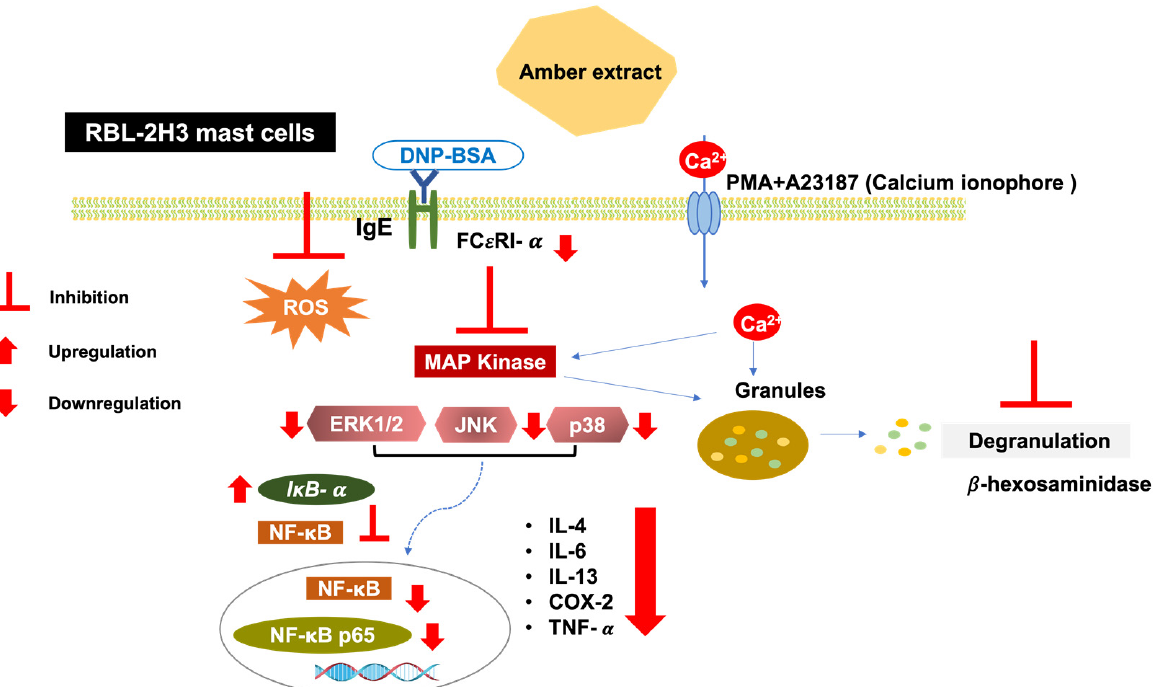
Figure 8. Schematic pathway summarizing the anti-allergy inflammatory effect of amber extract on RBL-2H3 cells. Antigen/IgE cross-linking with the mast cells’ specific receptor FC ε RI and calcium ionophore (A23187) induction activates the MAPK pathway. Amber extract decreases MAPK and NF- κ B pathway activation and therefore diminishes mast cell degranulation and cytokines produc- tion.